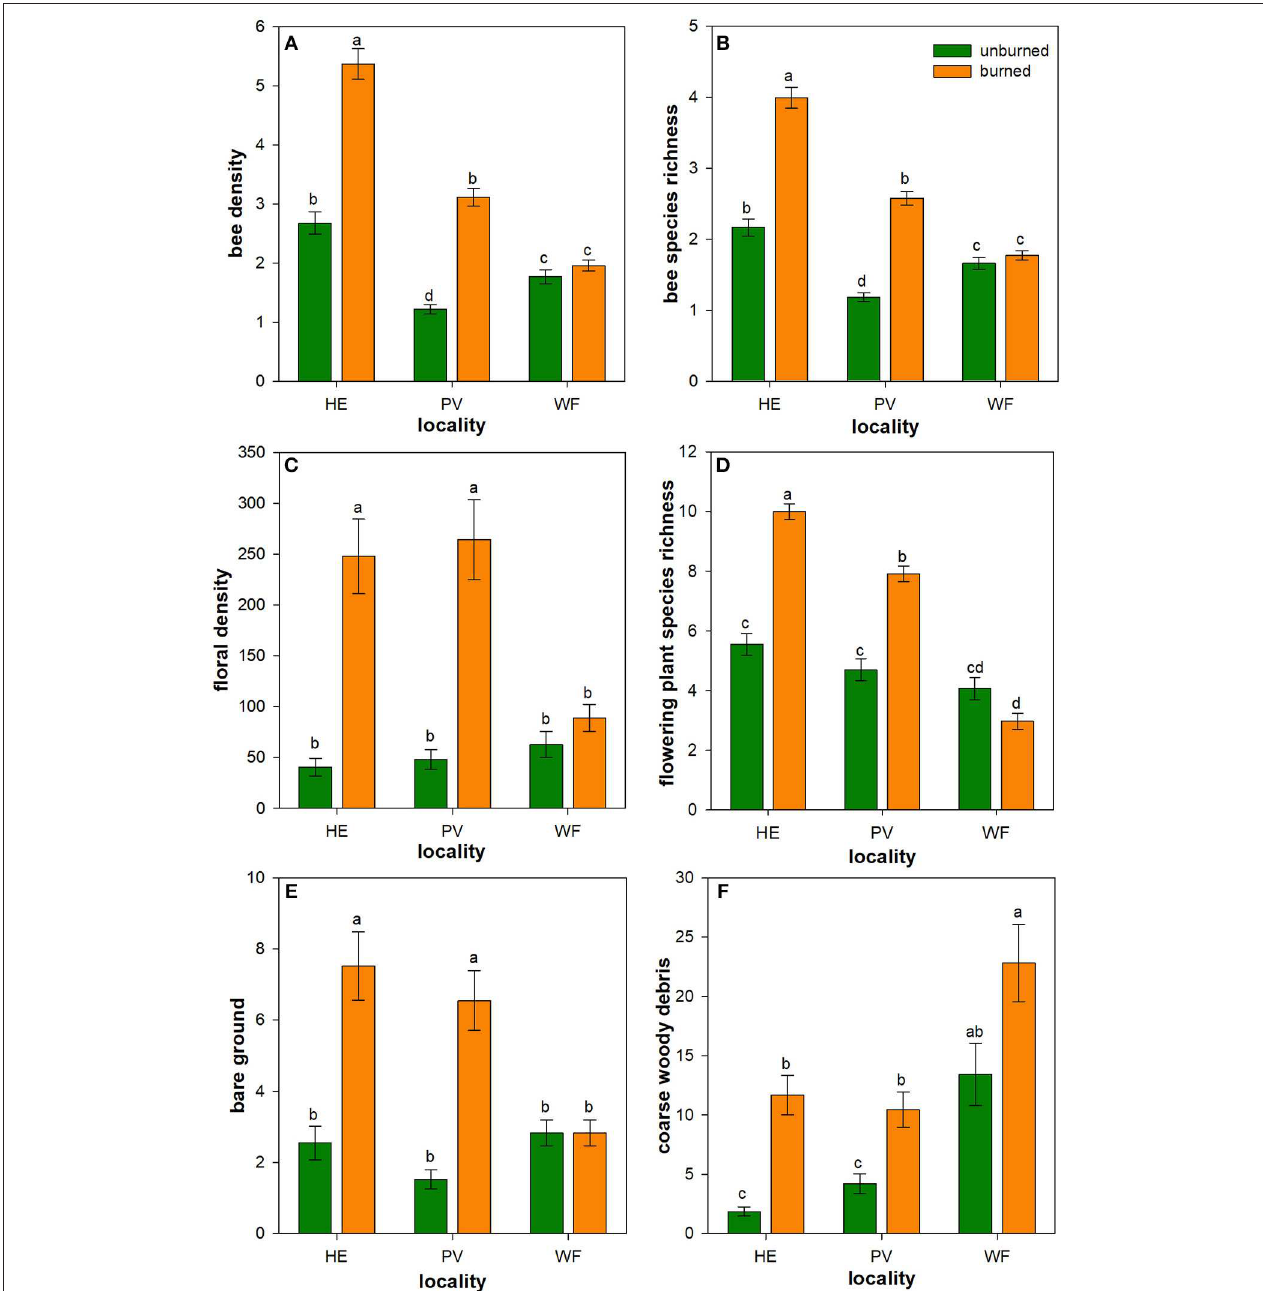
FIGURE 1 | Influence of wildfire on bees, floral resources, and nesting resources. Back-transformed least square means ( ± 1SE) of bee density (A) , bee species richness (B) , floral density (C) , flowering plant species richness (D) , bare ground (E) , and coarse woody debris (CWD) (F) were higher in burned plots (orange) than in unburned plots (green) in Helena (HE) and Paradise (PV), but not in Whitefish (WF). Letters represent significant differences in means at α = 0.05. N = 16–18 unburned plots per locality; N = 36 burned plots (mixed-severity and high-severity fires) per locality.